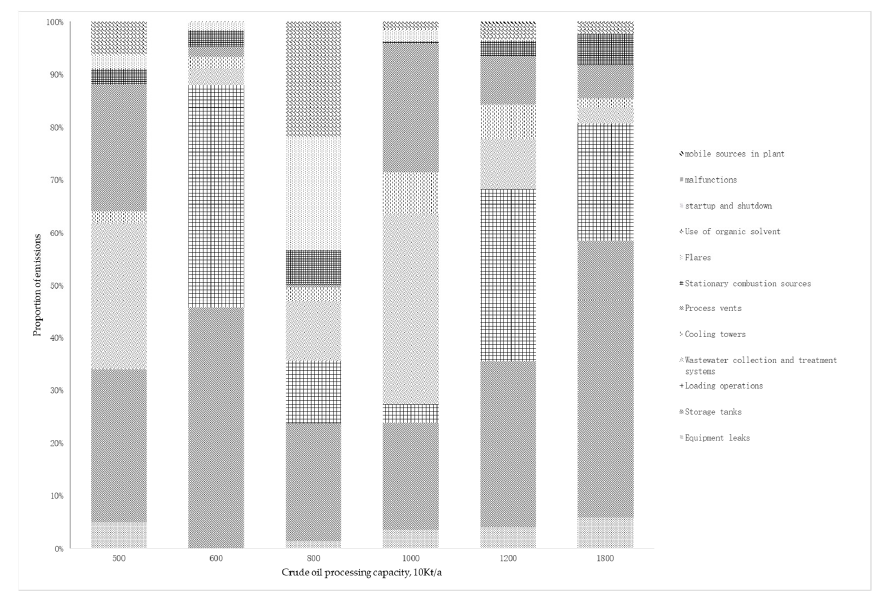
Figure 2. The proportion of emission source items of five investigated enterprises.